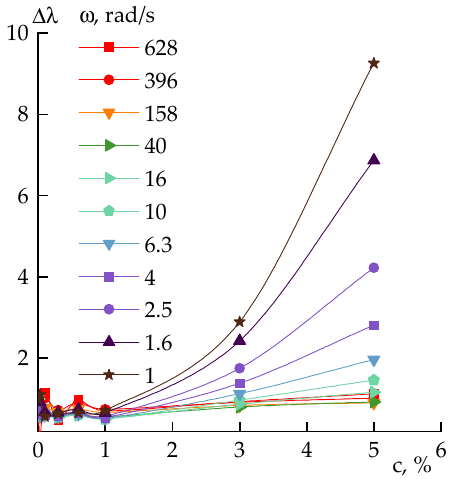
Figure 10. Dependence of the relative relaxation times on silica concentration at different frequency (indicated in plot). Silica concentration (c) is at the solution